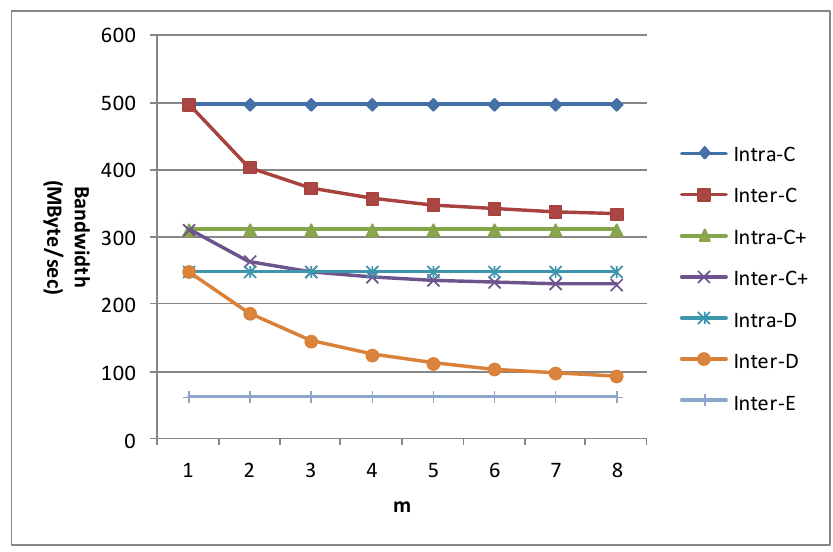
Figure 22. The bandwidth requirement of VC-MRME for 1080 p.